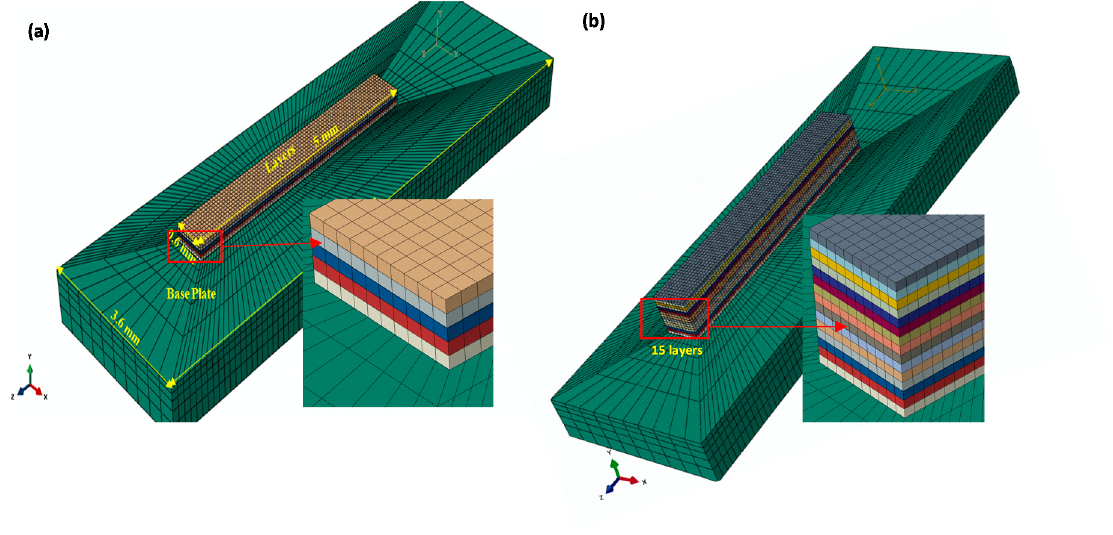
Figure 1. FE model of the EBM process, ( a ) with five layers, ( b ) with fifteen layers.